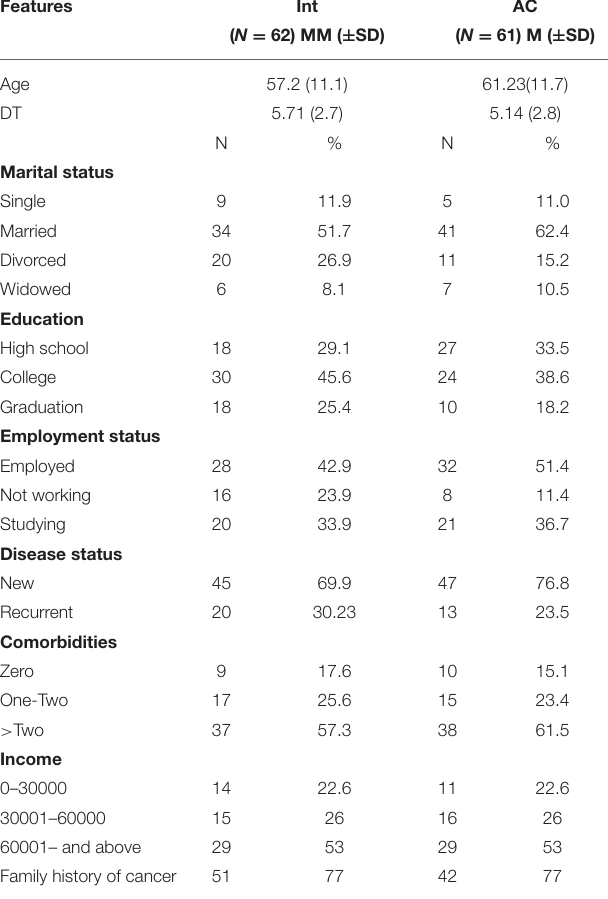
TABLE 2 | Demographic details of the